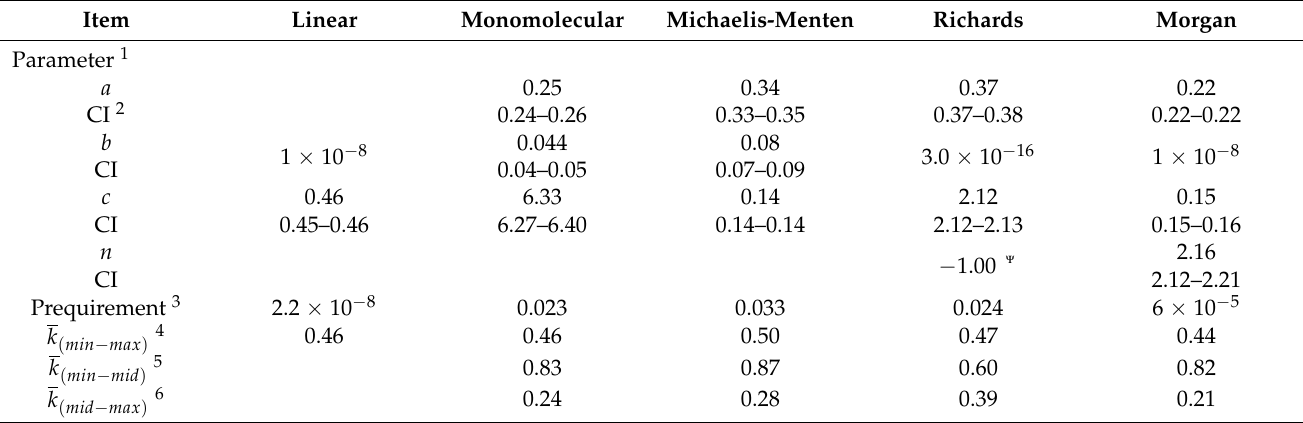
Table 2. Parameters estimates, and associated 95% confidence intervals, resulting from fitting linear and non-linear models to P retention vs. P intake (g kg–1 BW0.75 d–1) data in growing and finishing pigs, derived P requirement for maintenance in addition to average efficiency ( k ) of dietary P conversation to retained P.